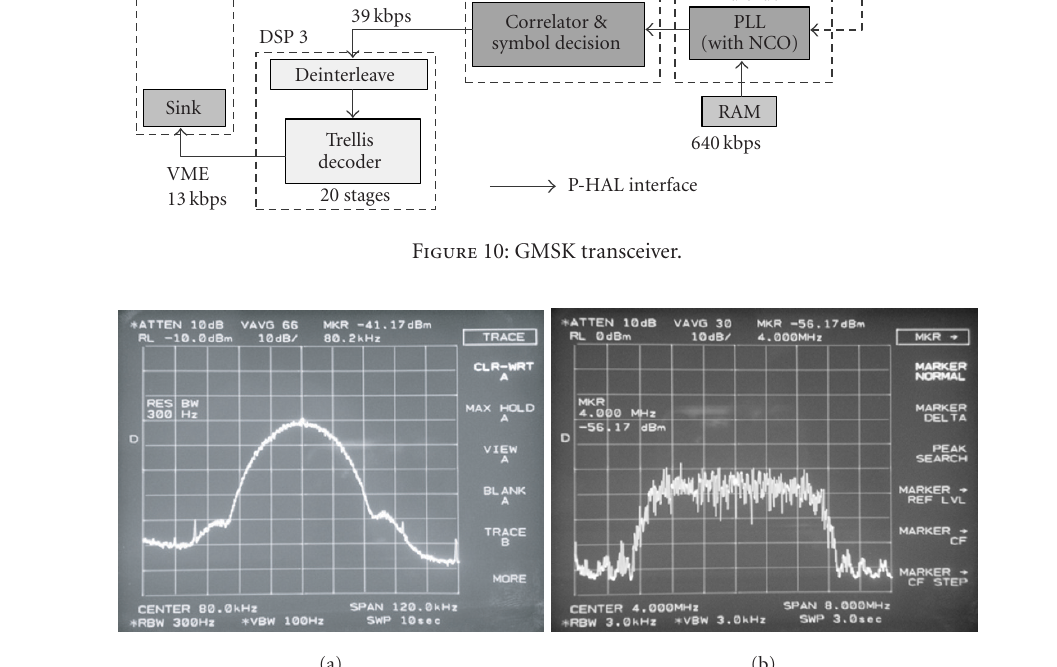
Figure 11: GMSK and QPSK CDMA generated